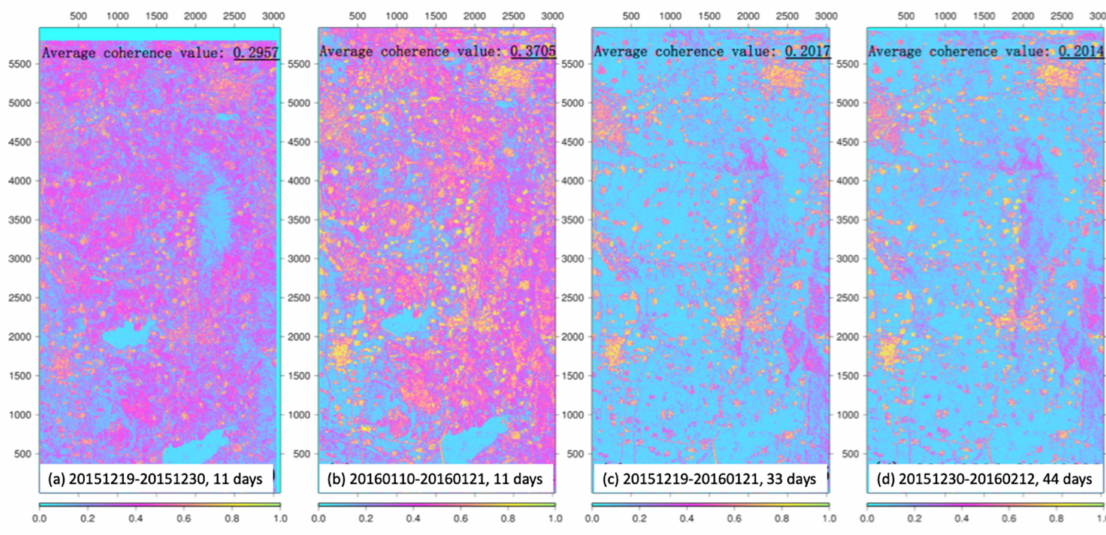
Figure A1. The examples of the coherence maps of TSX